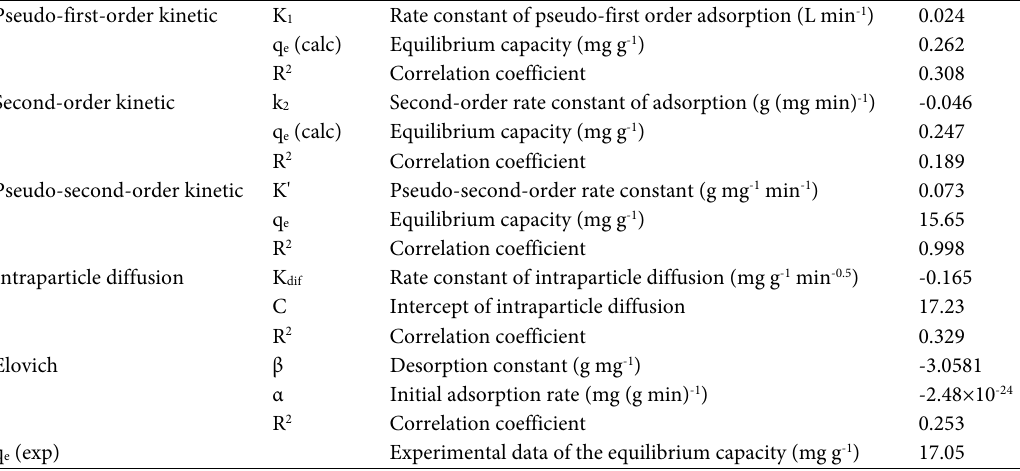
Table 7. Adsorption kinetic parameters at different initial MO onto70 mg of NFNs in 50 mL at pH 5.5, room temperature and MO concentration of 50 mg L -1 .